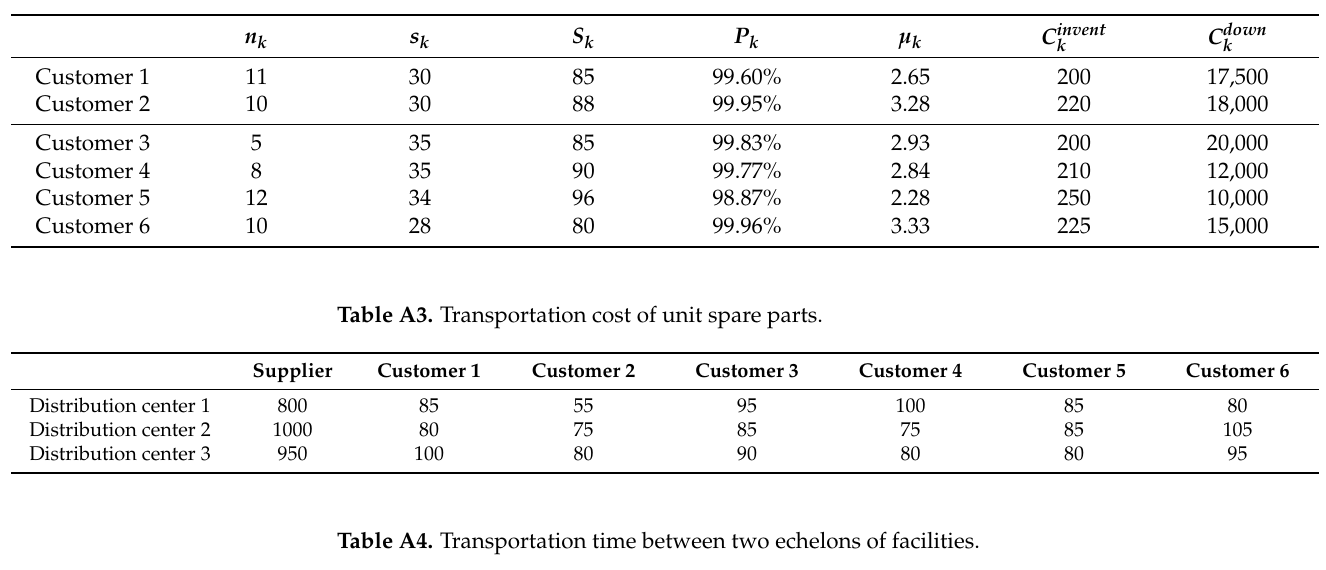
Table A2. Parameters of spare part supply network and inventory control policy.